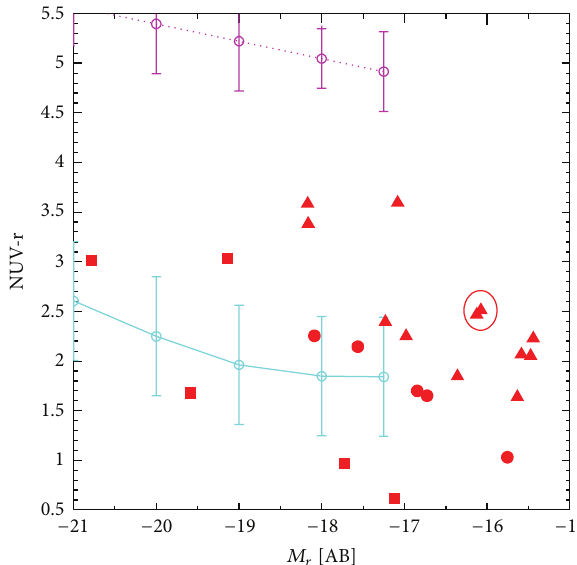
Figure 3: The CMD (NUV-r) versus 𝑀 𝑟 of the CVnI Cloud members. The Wyder et al. [25] fits of the blue and red sequences (cyan/magenta lines) are plotted, including their error bars. The oval indicating the position of UGC 7639 also includes UGC 7408, a galaxy slightly bluer and brighter than our dwarf. Different symbols correspond to different SFRs: squares are for SFR ≥ 0 . 1 M ⊙ /yr, triangles for SFR ≤ 0 . 05 M ⊙ /yr, and circles for SFRs in between.